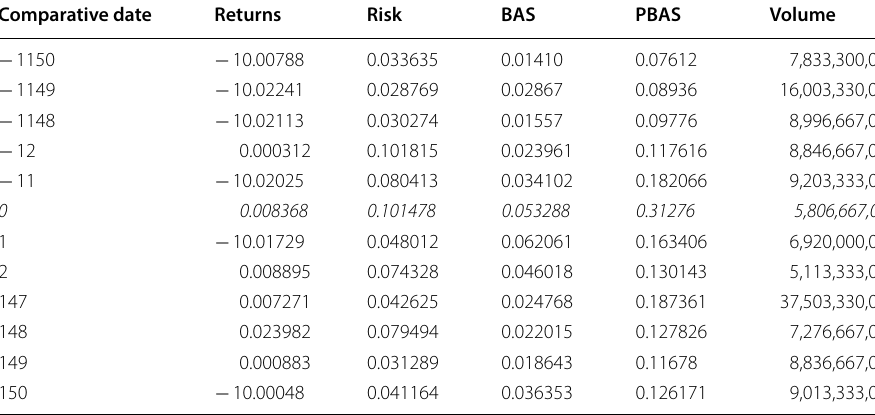
Table 2 Cross-sectional average sample